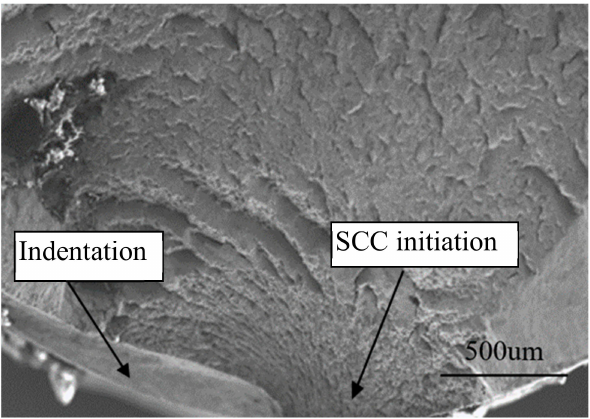
Figure 19. Crack initiation at the indented